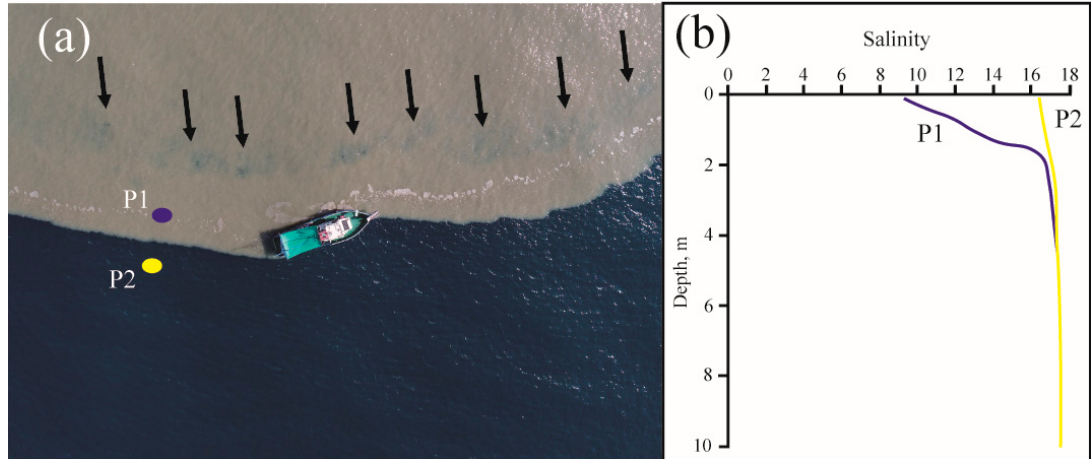
Figure 15. ( a ) aerial image and ( b ) vertical salinity profiles at the undulate border of the Kodor plume on 1 September 2018. Colored dots indicate locations of vertical salinity measurements (P1, blue—the plume; P2, yellow—the ambient saline sea). Black arrows in panel ( a ) indicate a stripe of low-turbid water within the Kodor plume stretched along its border.